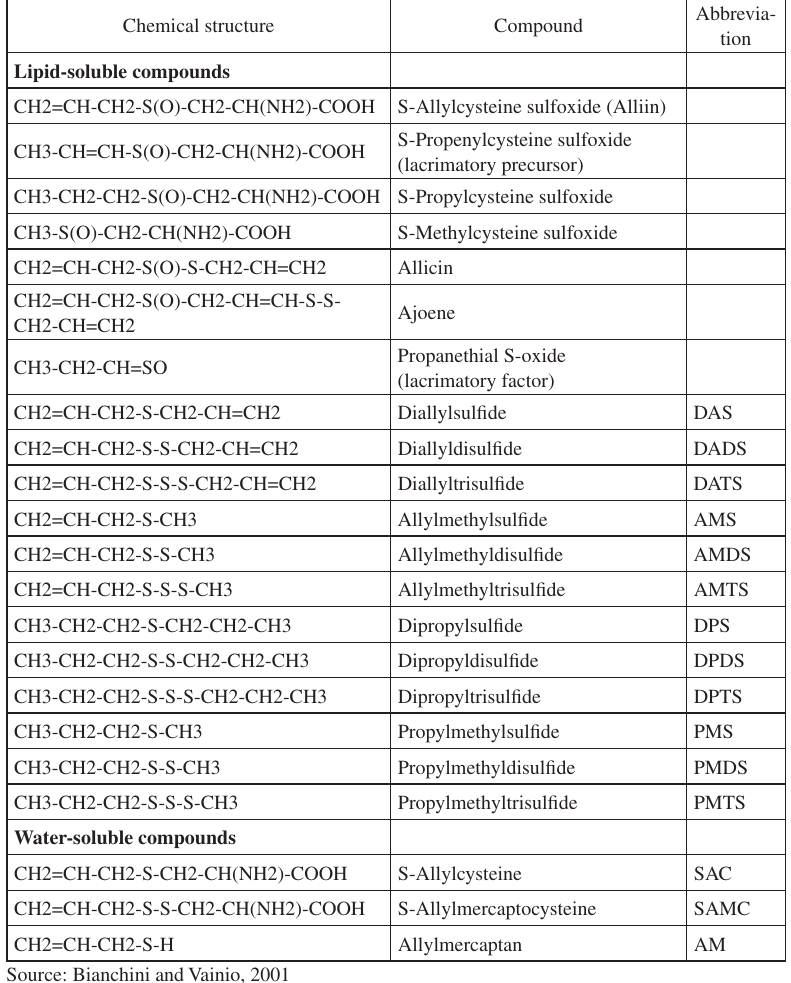
Table 3. Main organosulfur compounds present in Allium vegetables Chemical structure Compound